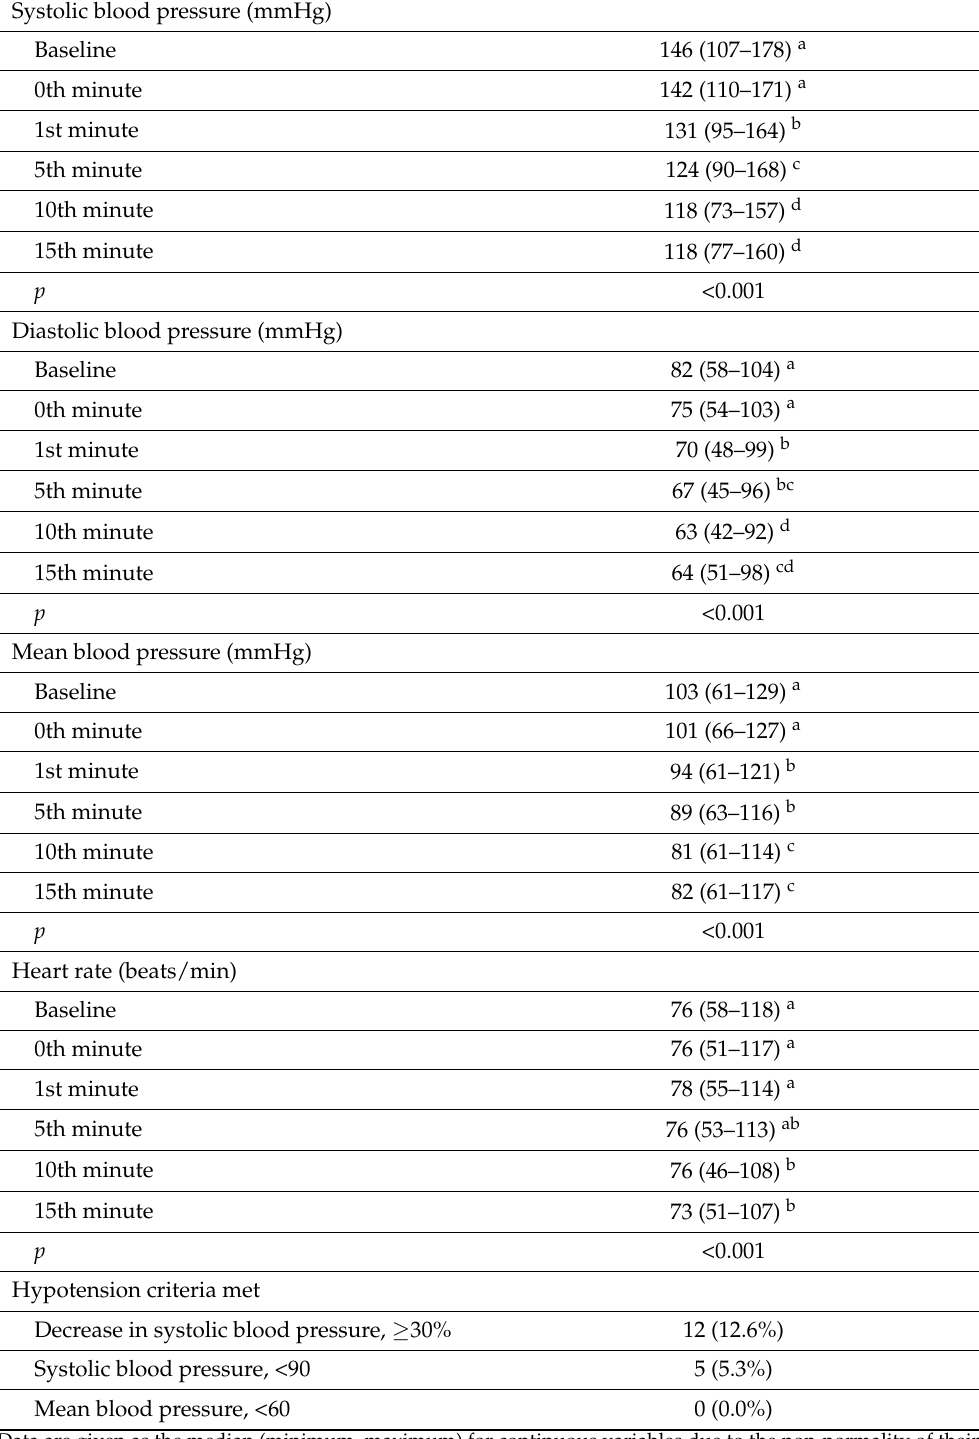
Table 2. Summary of other measurements performed in the